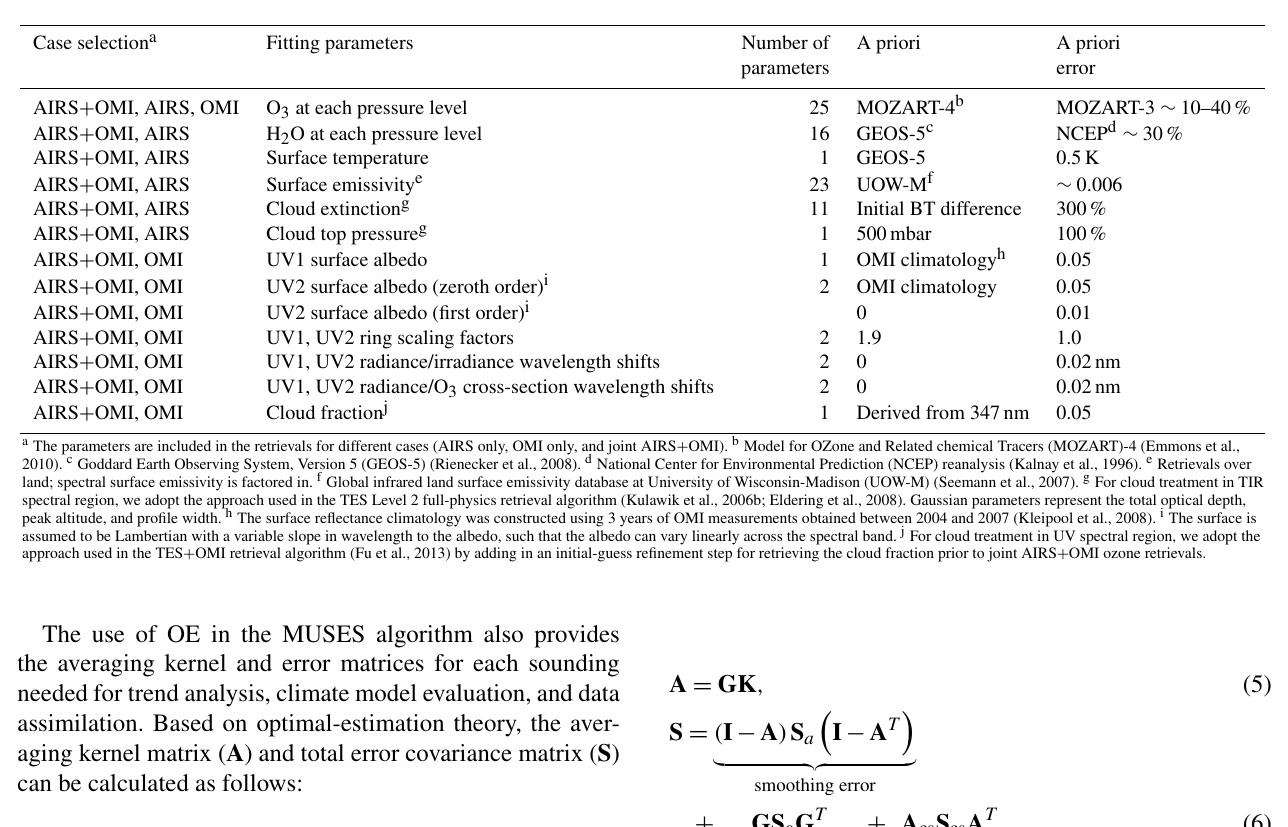
Table 2. List of parameters in state